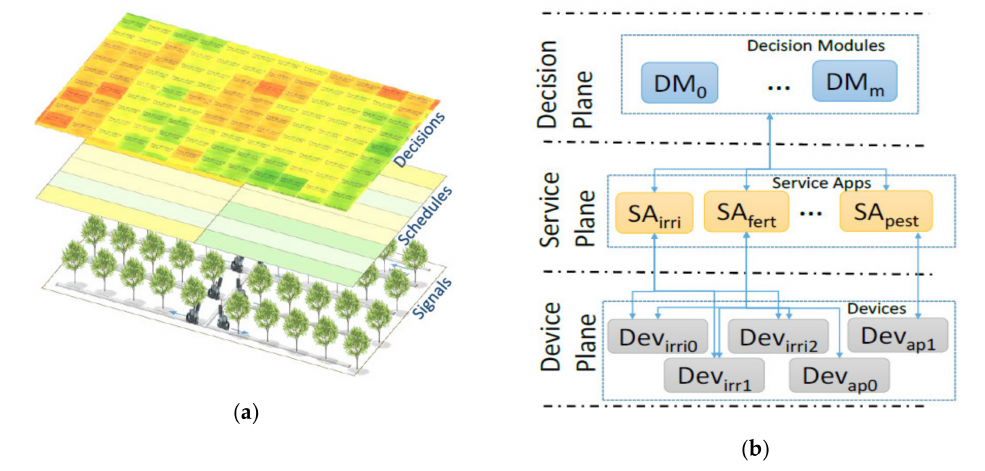
Figure 1. ( a ) Decision support system (DSS) software structure reported in [5] and ( b ) its three-layer architecture with decision, service and device planes,